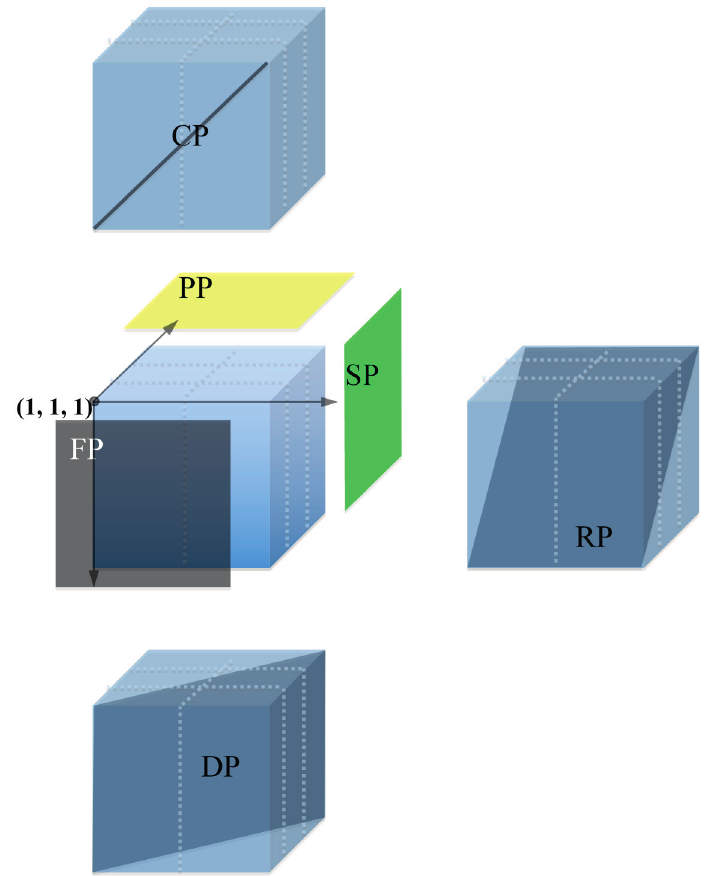
Figure 3. Diagram of 6D pools. Grid made by 288 384-well plates was arranged in 48 layers × 48 rows × 48 columns containing 110,592 clones. Plate pool (PP), face pool (FP), side pool (SP), row pool (RP), column pool (CP), and diagonal pool (DP) were generated as shown, each pool contains 2304